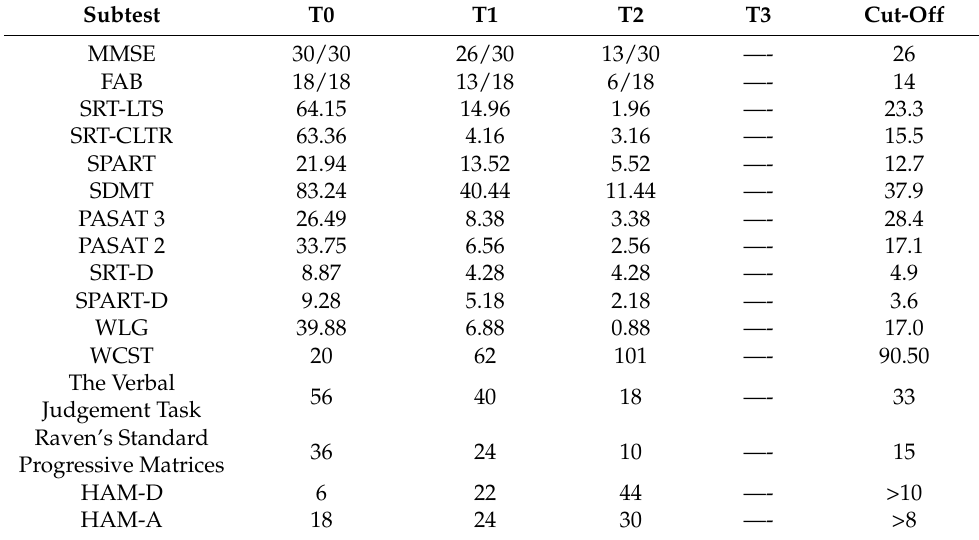
Table 1. Comparison of neuropsychological score, before PML related-natalizumab diagnosis (T0) at the onset of the first symptoms of PML (T1), 30 days after hospitalization (T2) and 60 days after hospitalization (T3). The cut-offs refer to the Italian calibration of the tests